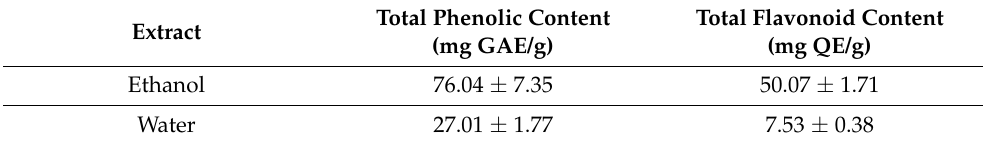
Table 1. Phytochemical analysis of P. australis extracts.